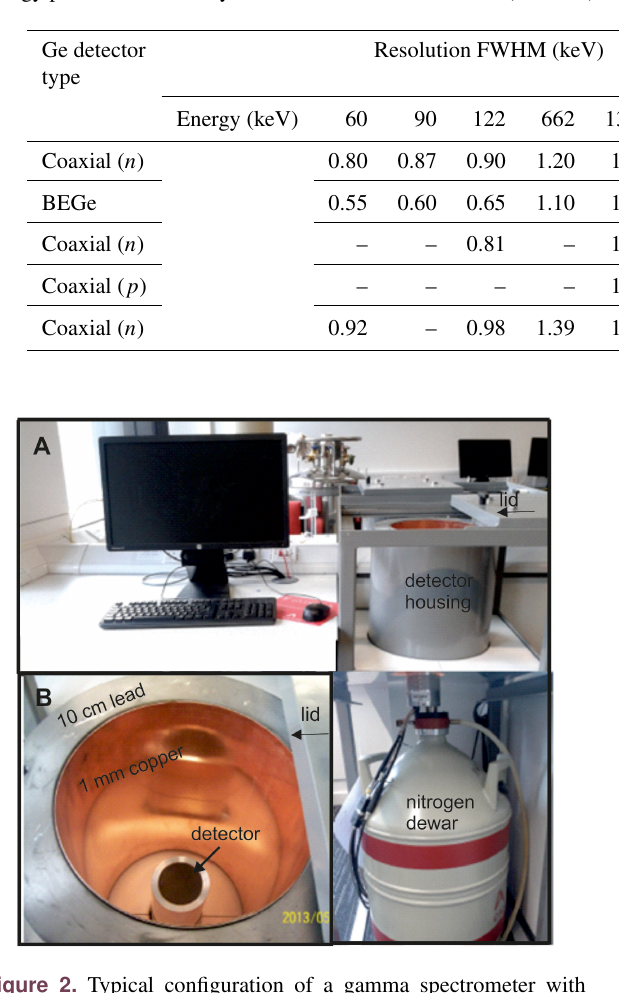
Table 1. Properties of commonly used Ge detectors in terms of diameter, length, and peak resolution. FWHM: full width half-maximum of energy peak. The efficiency is relative to a sodium–iodide (3 × 3in.) detector taken at 25cm.